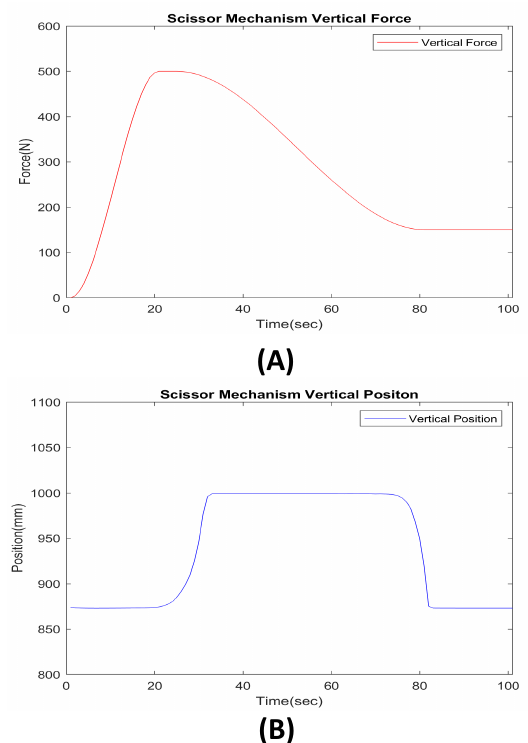
Figure 11. Scissor mechanism CAE analysis results data. ( A ) The vertical force was generated by the scissor mechanism for lifting a 50-kg object (0 to 500 N). ( B ) Scissor mechanism vertical position. The position of the object rises as the scissor mechanism generated force in the direction of gravity (initial position 850 mm to final position 1000 mm).